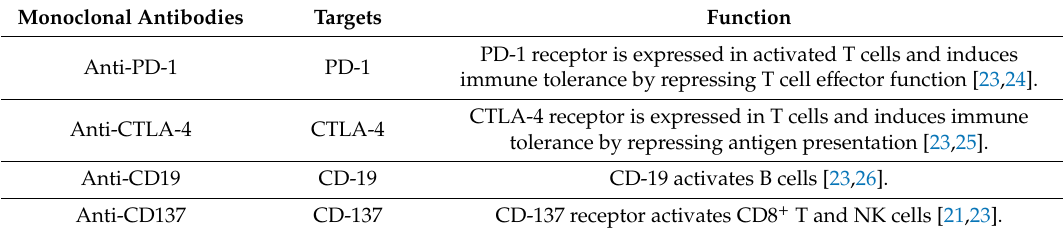
Table 1. Monoclonal antibodies for the treatment of lung tumors in mice. Monoclonal Antibodies Targets Function PD-1 receptor is expressed in activated T cells and induces Anti-PD-1 PD-1 immune tolerance by repressing T cell e ff ector function [23,24]. CTLA-4 receptor is expressed in T cells and induces immune Anti-CTLA-4 CTLA-4 tolerance by repressing antigen presentation